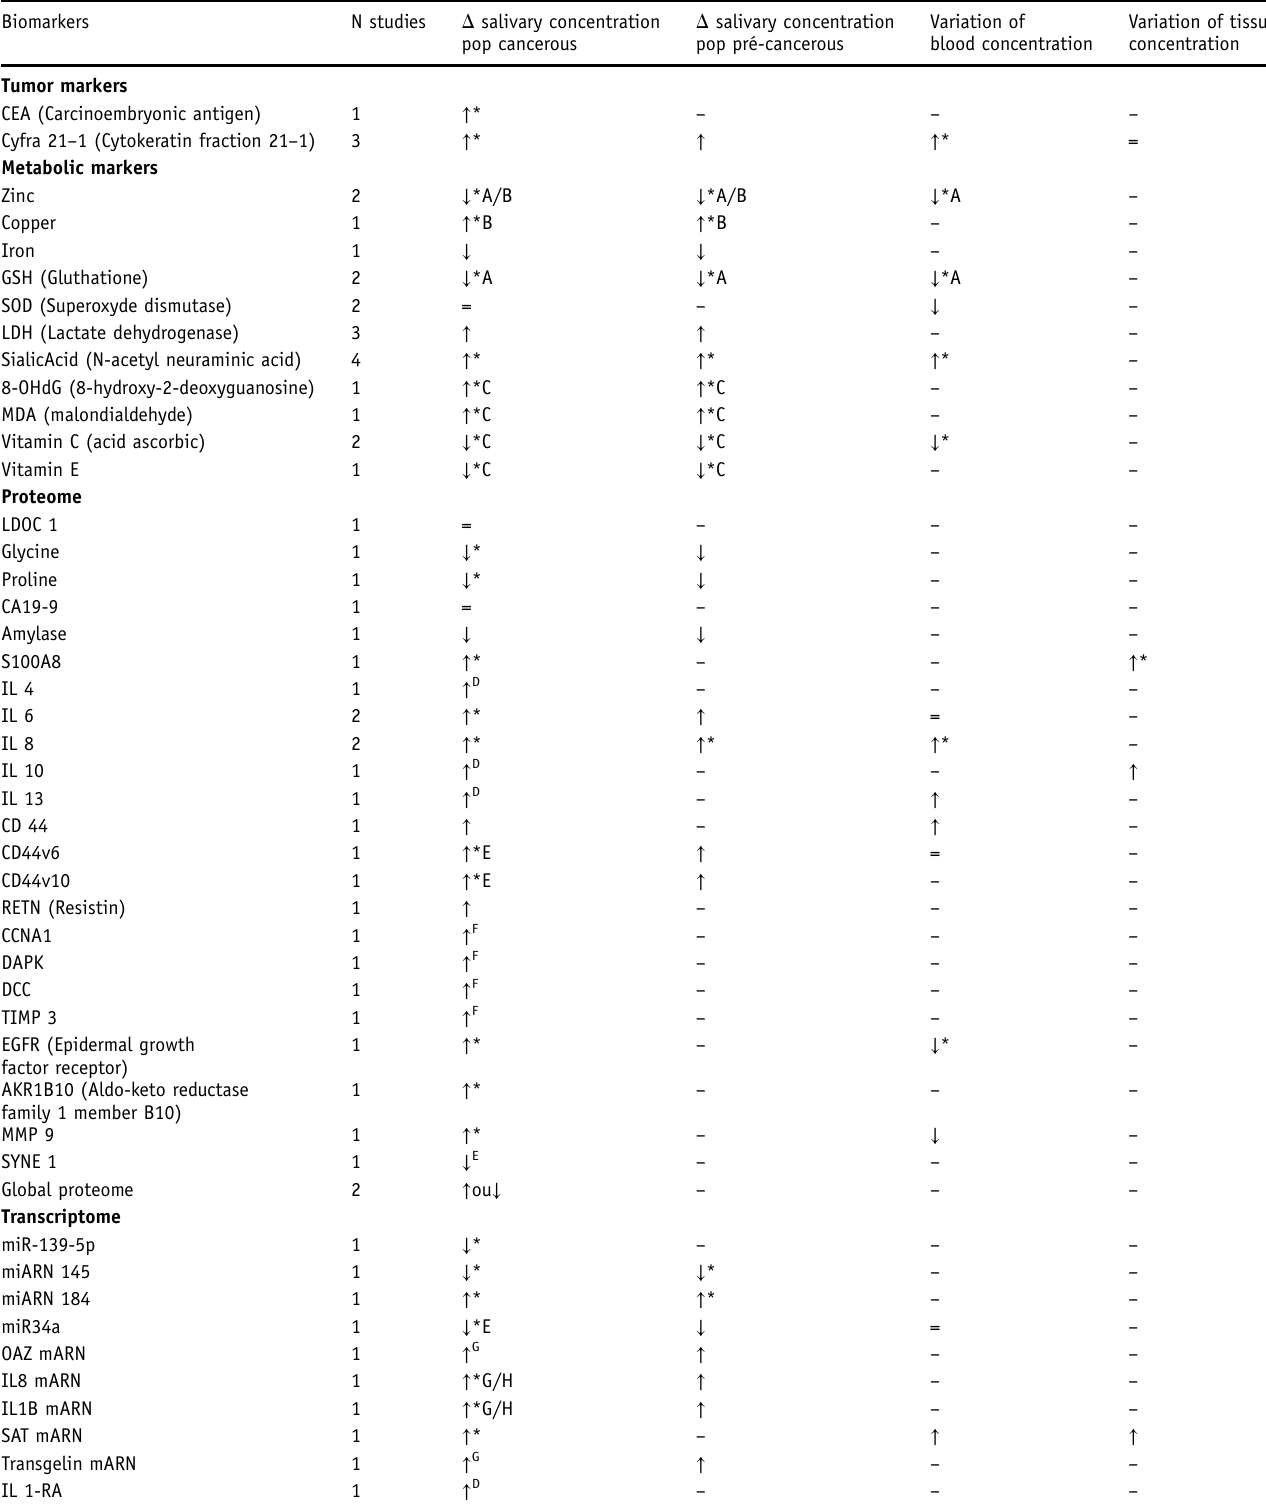
Table II. Summary of published concentrations by biomarkers and by population